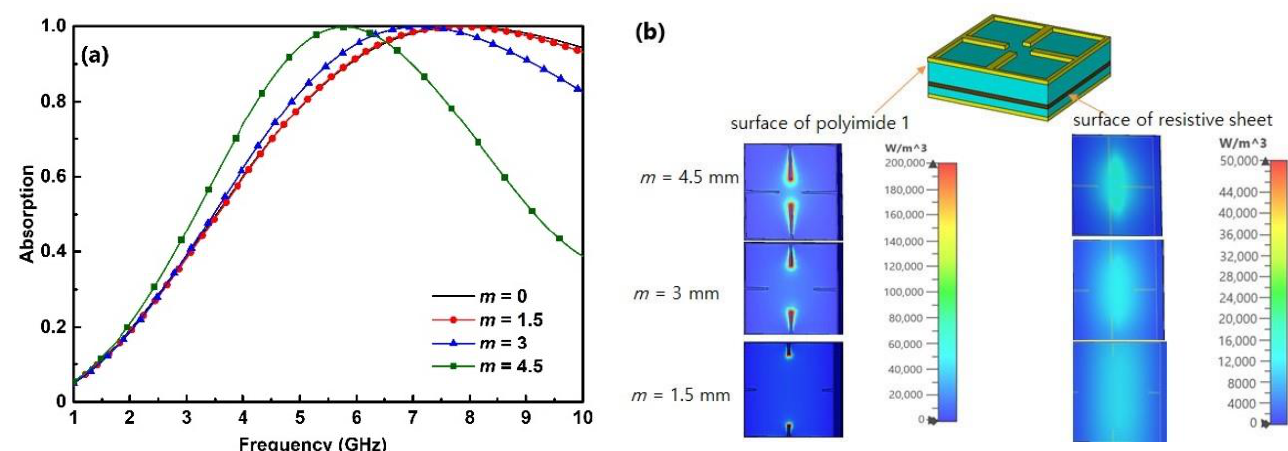
Figure 4. ( a ) Absorption and transmission spectra of the ET and MA structures. ( b ) Distributions of the surface current (in arrow) and magnetic field (in dot) in the ET and MA structures.